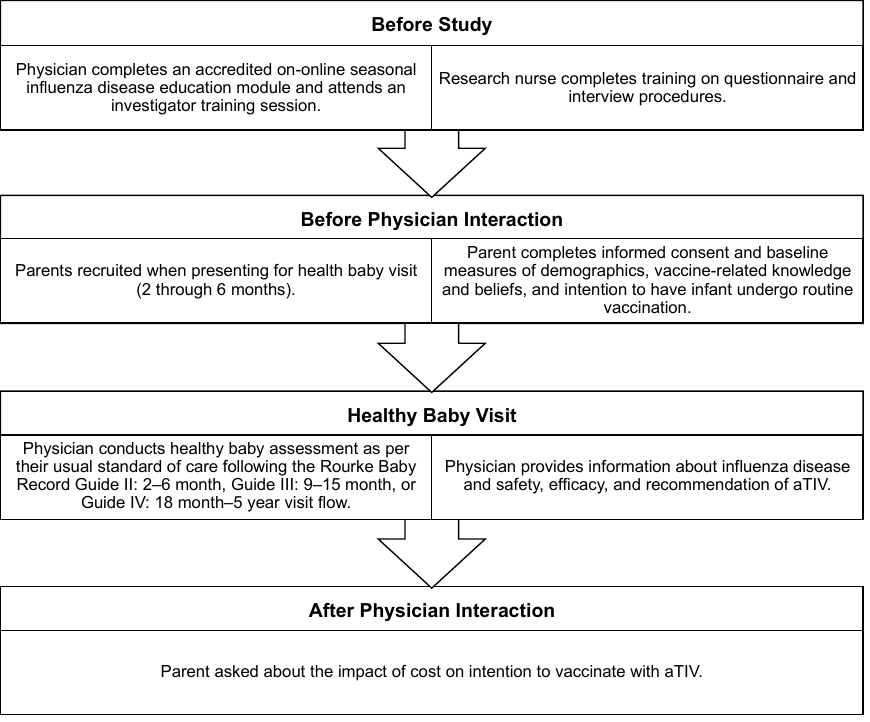
Figure 1. Study recruitment procedures and protocol flow.